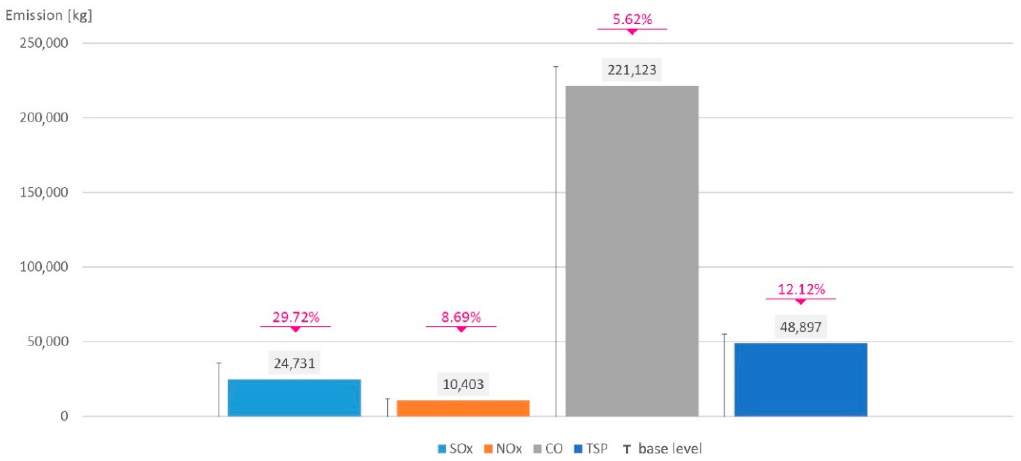
Figure 8. Annual emissions of pollutants in Model 2: 25% coal, 70% biomass, 5% fuel oil.